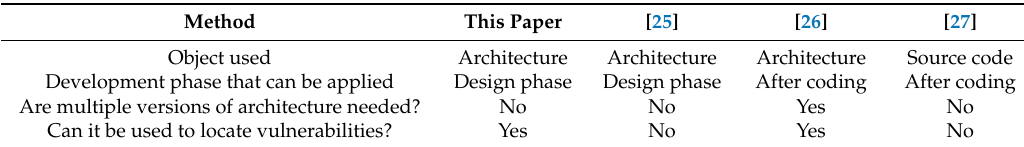
Table 12. Comparison with other